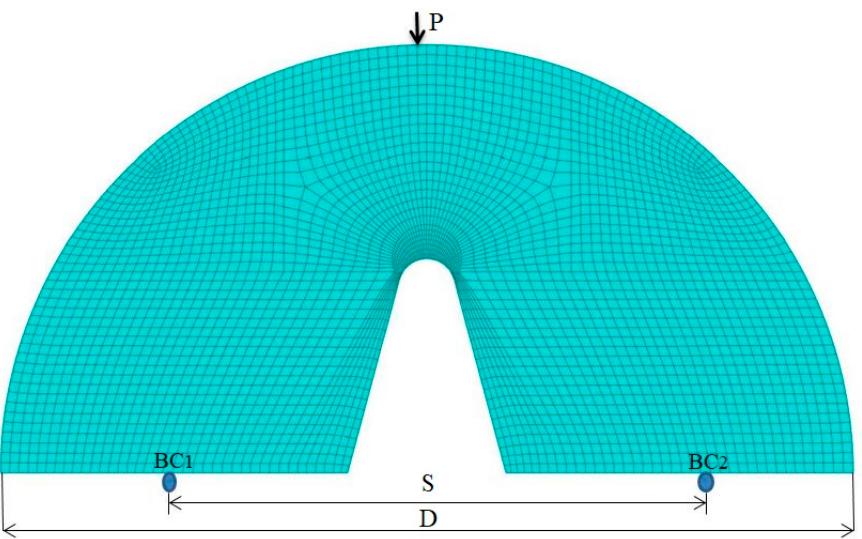
Figure 8. FE model of an SCB test specimen containing a blunt V-notch (2 α = 30°).